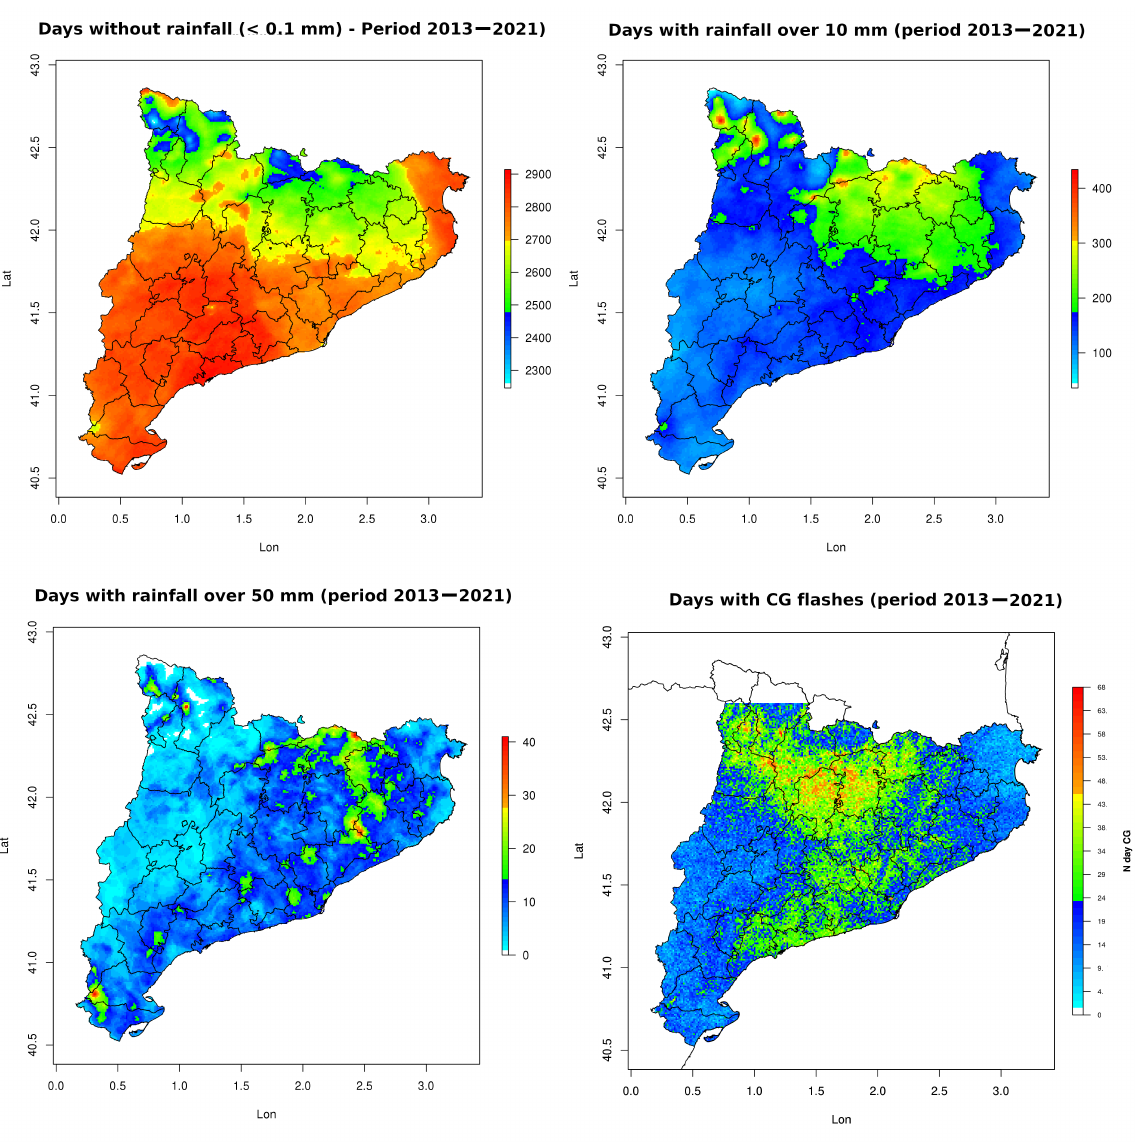
Figure 2. From left to right and top to bottom: Map of the number of days without precipitation (below 0.1 mm) for the period of 2013–2021; the same as that of the previous but for days with precipitation over 10 mm and for days with precipitation over 50 mm; days with cloud-to-ground